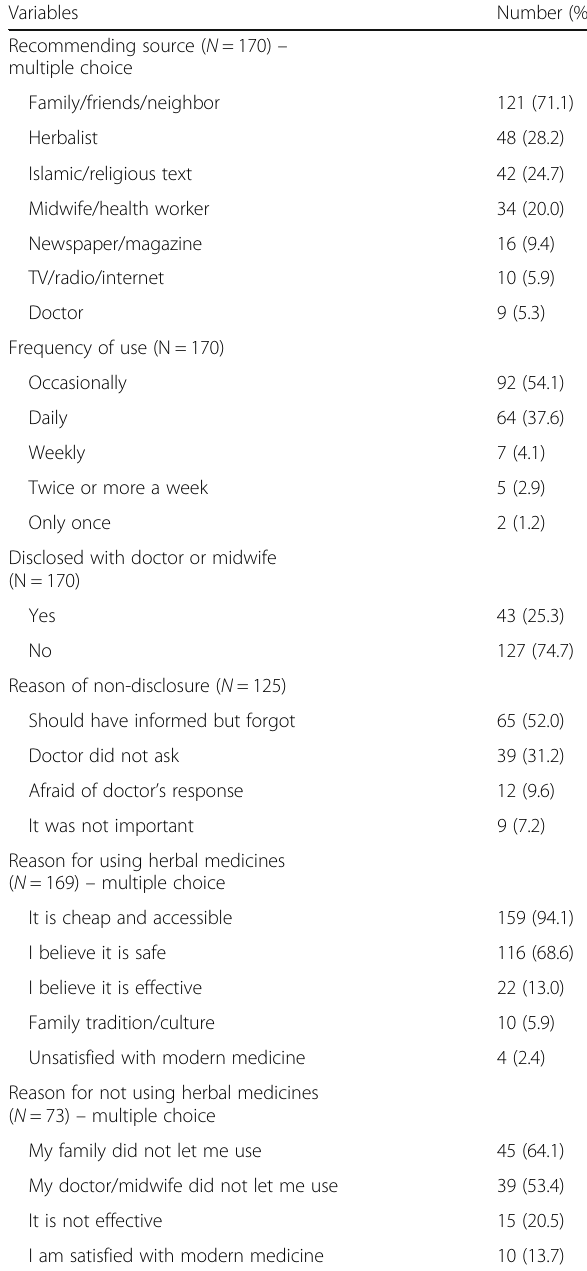
Table 5 Patterns of herbal medicine use during pregnancy Variables Number